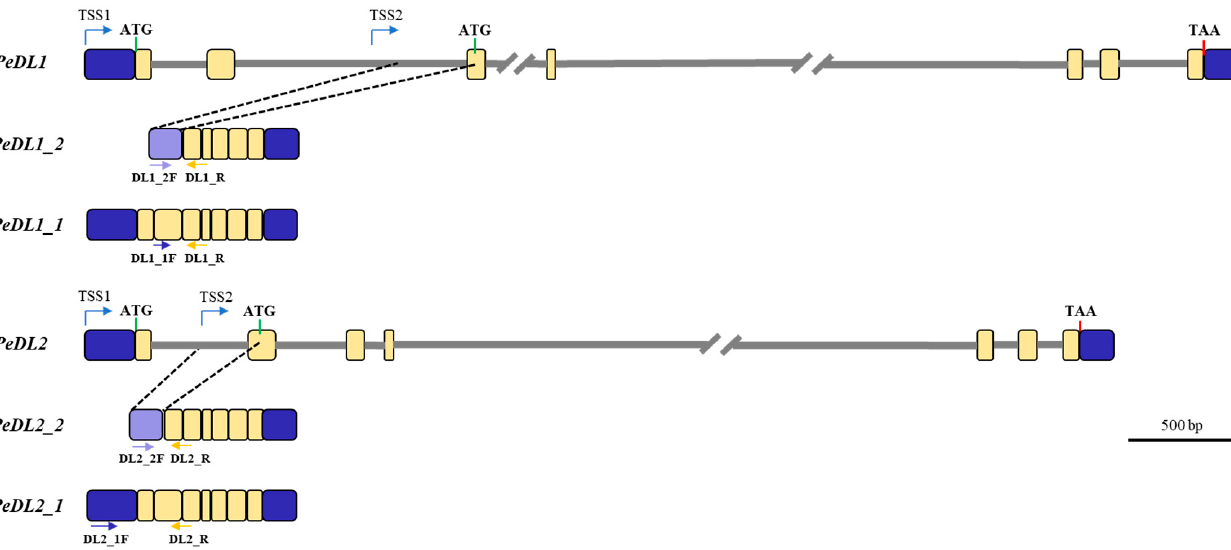
Figure 2. Genomic organization of the PeDL1 and PeDL2 transcribed regions of P. equestris and diagram of the corresponding alternative transcripts. The blue boxes represent the 5 (cid:48) - and 3 (cid:48) -UTRs; the yellow boxes represent the coding regions, the gray lines represent the introns. Introns of unknown size are shown as interrupted gray lines. The green and red bars indicate the position of the translation start (ATG) and stop (TAA) codons, respectively. TSS1 and 2 are the putative alternative transcription start sites of the different isoforms. The blue and yellow arrows indicate the position of the isoform-specific primer pairs.